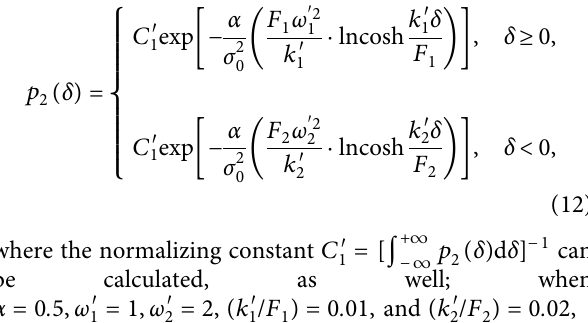
the displacement PDFs of AHTNPS can be plotted for various values of σ 2 representing the excitation grade in 0 Figure 11. In comparison with the numerical solutions of the displacement PDFs of AHTNPS, leading to further verify the theoretical model, the displacements δ move lower and wider as the excitation intension increases. Figure 12 depicts the displacement PDFs of AHTNPS with different α . As the cushion capacity of the system decreases with decrease in α the displacement response varies over a larger range, and the system damping is considered as linear, but the nonlinear stiffness factors were expended in the ( δ ) presents distinct non-Gaussian characters. system, and p 2